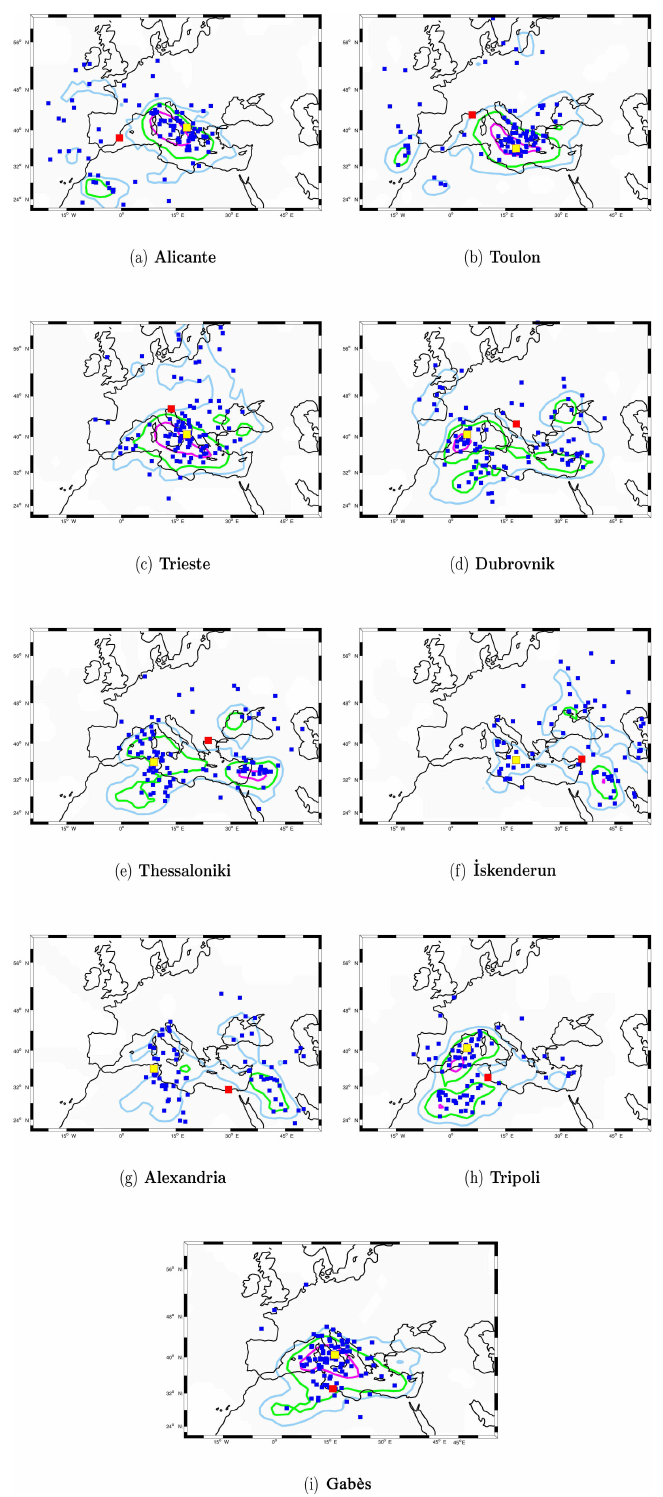
Figure 7. The same as Fig. 6, except referring to large negative sea level anomalies and to Table 3.